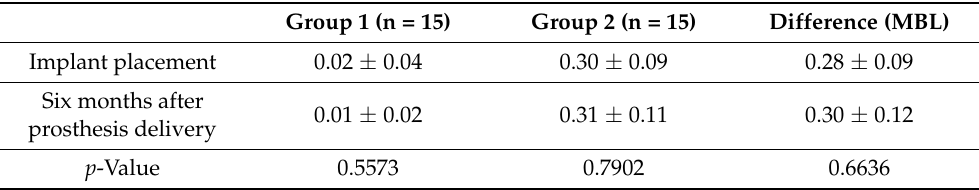
Table 3. Marginal bone levels between groups.